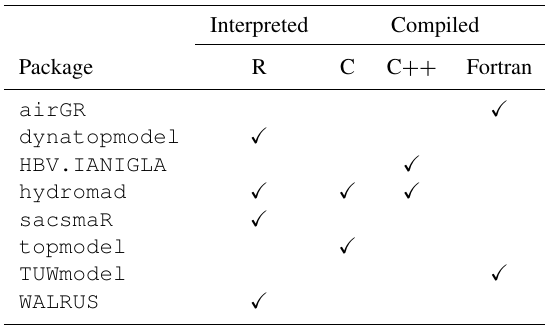
Table 9. Programming languages of the models used in the selected R